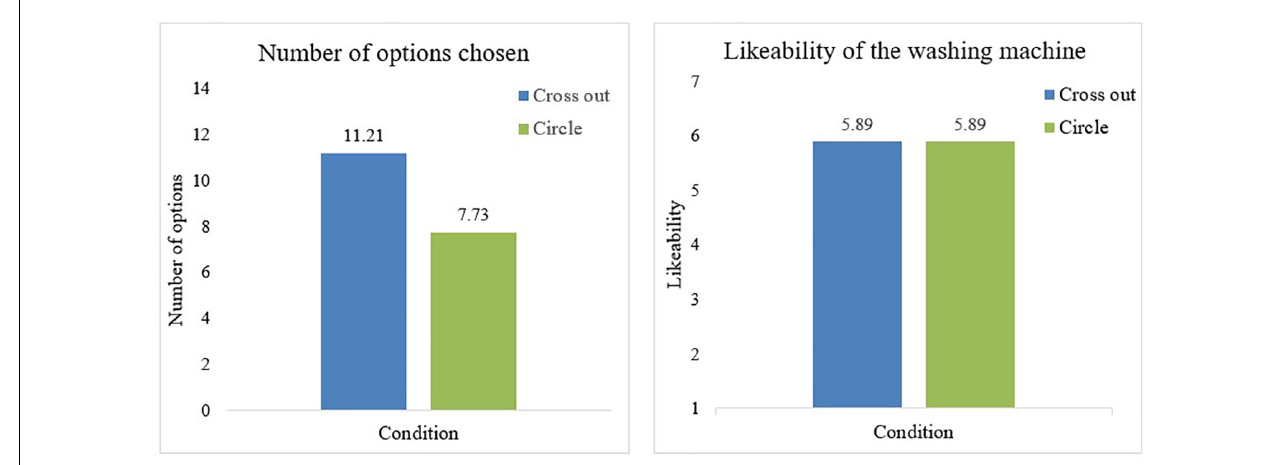
FIGURE 1 | The mean number of options chosen and likeability of the chosen washing machine per condition.